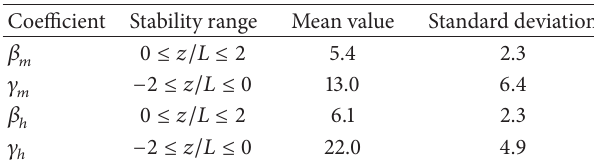
Table 3: Coefficients of nondimensional profile functions a